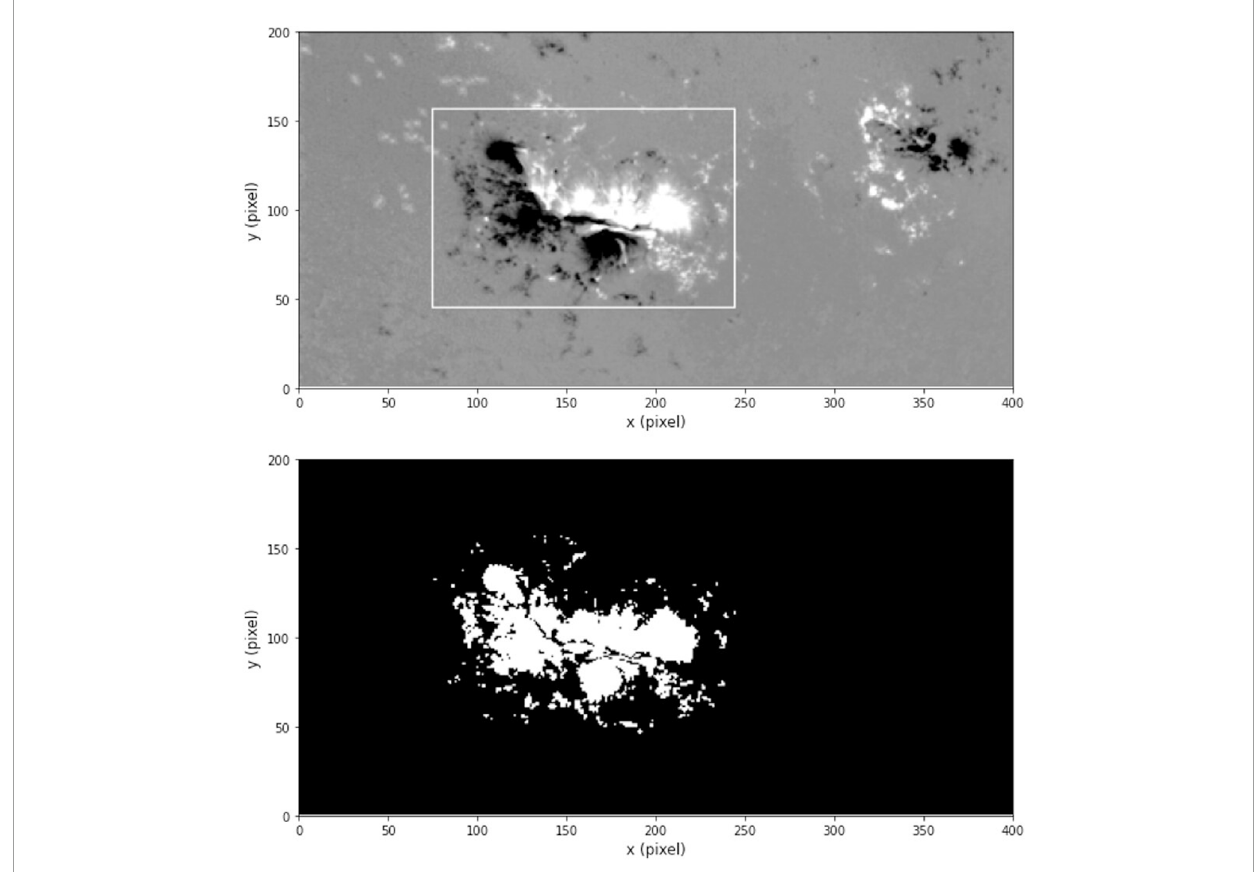
FIGURE 4 (Top) The HMI measured magnetogram from 2012-03-07 00:00UT with box around NOAA AR 11429. (Bottom) The 00:00UT AR defined as region with | B z | ≥ 300 G within the boxed in